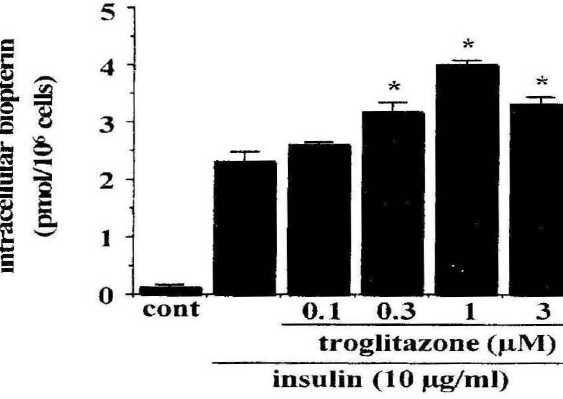
Figure 1. Effect of troglitazone on insulin-induced increase in BH4 content in endothelial cells. Cells were incubated with insulin (1 0 ~tg/ml) in the presence or absence of troglitazone (0.1-3 ,....M) for 24 h. Typical data from 3 experiments are shown as mean - S.E.M. of quadruplicate assays. *Significantly different from insulin-treated group